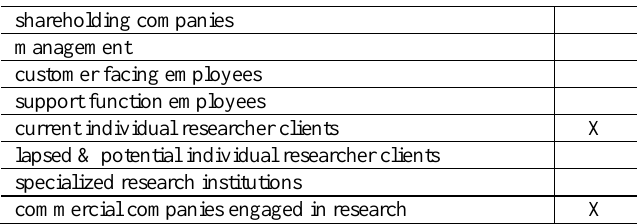
Table 7: Participants loading on Factor